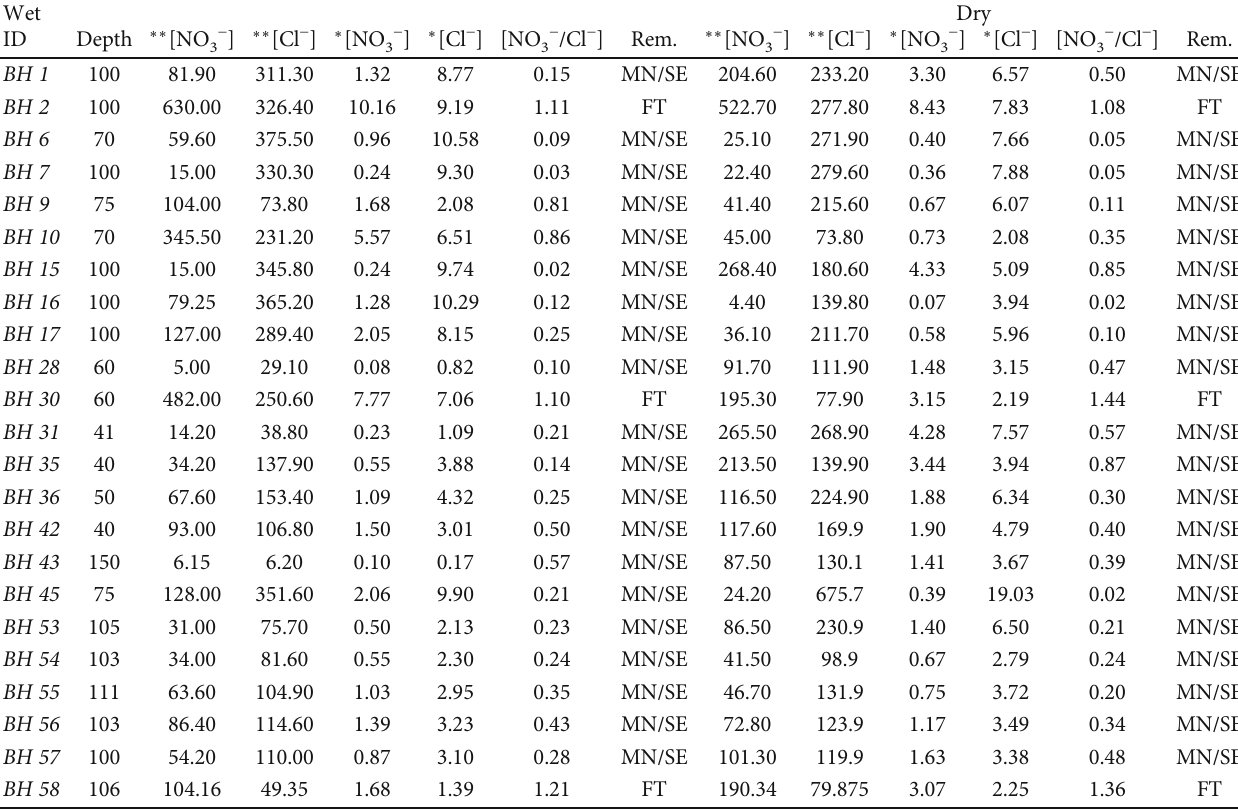
Table 3: Identi fi ed nitrate sources in boreholes using the nitrate-chloride ratio during the wet and dry seasons. Wet